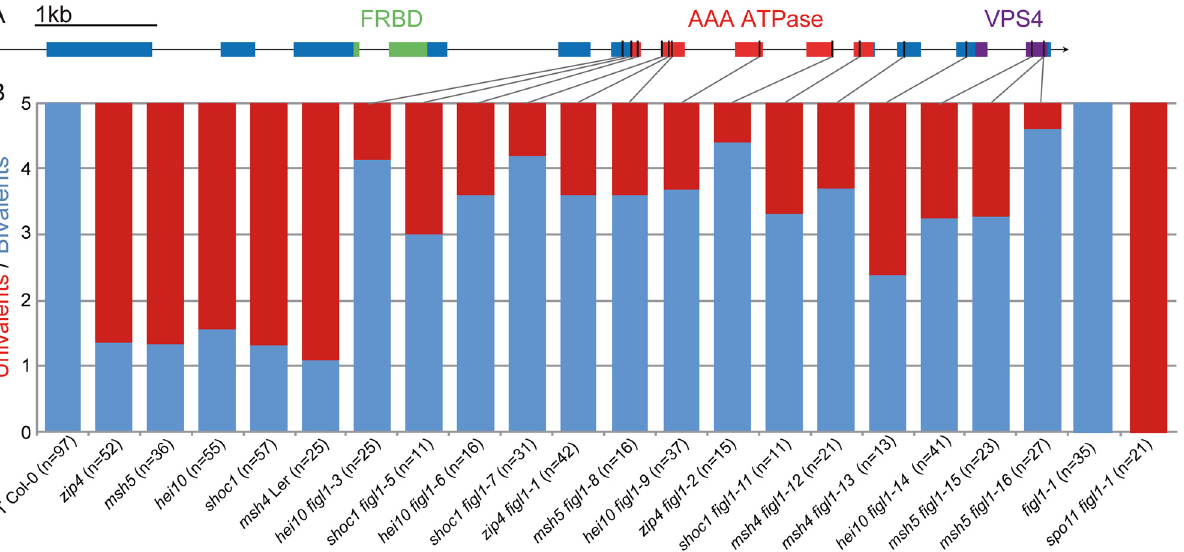
Fig 1. Mutations in FIGL1 restores bivalent formation in zmm mutants. A: Gene model of the FIDGETIN-Like-1 gene, exons appear as blue boxes, the conserved domains are indicated in green, red and purple. Black lines represent the position of the point mutations. B: Univalent pairs (red) and bivalents (blue) count of metaphase I male meiocytes in wild type, zmm mutants ( zip4 , msh4 , msh5 , hei10 and shoc1 ) and in zmm figl1 double mutants, as well as figl1 single mutants and figl1-1 spo11 double mutants. All genotypes are in a Columbia-0 background, except for msh4 figl1-12 and msh4 figl1-13 which are in a Landsberg erecta background